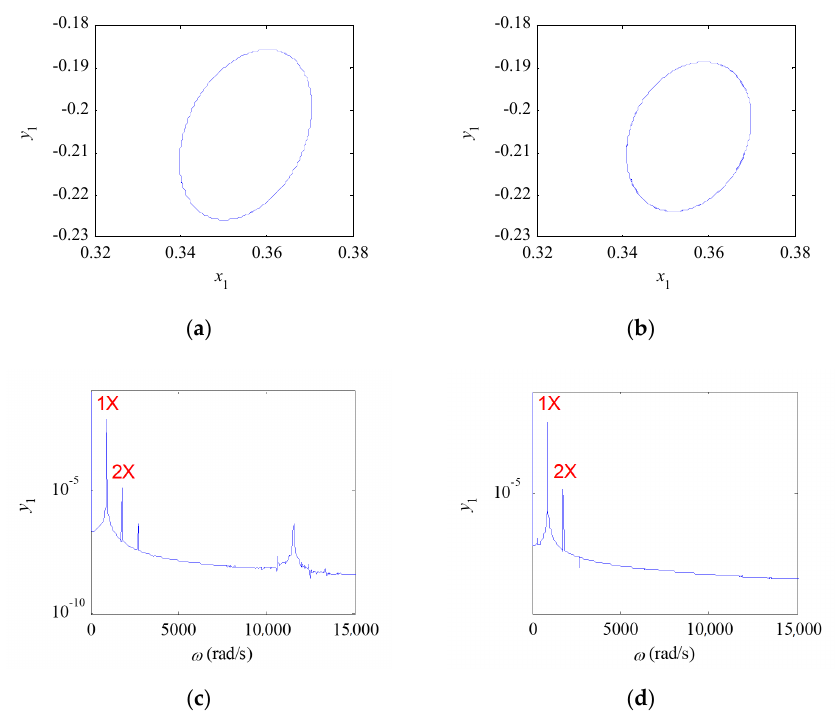
Figure 5. Comparisons between POM of 2-DOFs obtained by the optimal sampling length at ω = 350 rad/s and the original system (O-S) for axis orbit and frequency spectrum at ω = 900 rad/s: ( a ) axis orbit of O-S, ( b ) axis orbit of POM, ( c ) frequency spectrum of O-S, ( d ) frequency spectrum of POM.